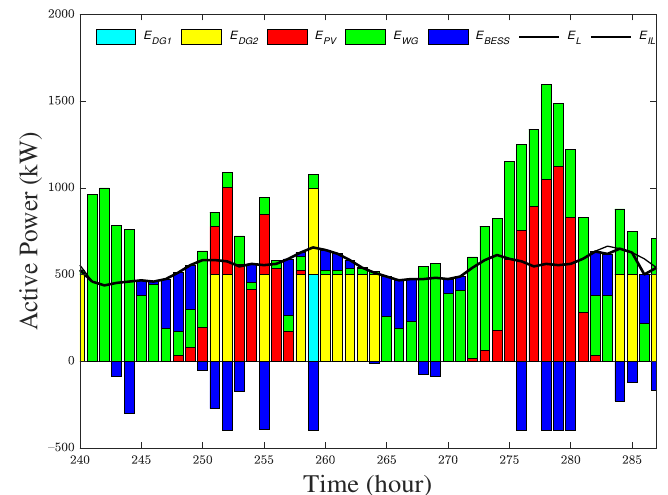
Figure 9. Operation schedule of 2 days (Case 2).